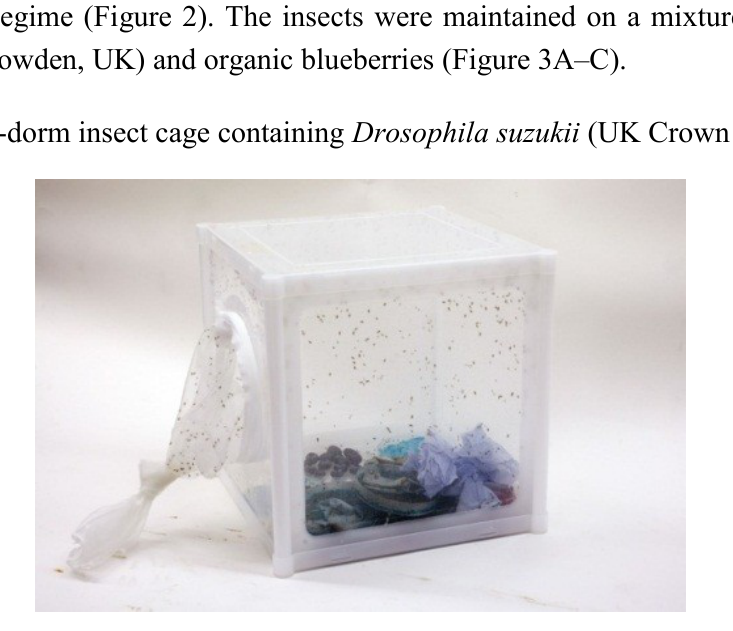
Figure 3. ( A ) Drosophila suzukii larvae developing in Drosophila diet ( Blades Biological